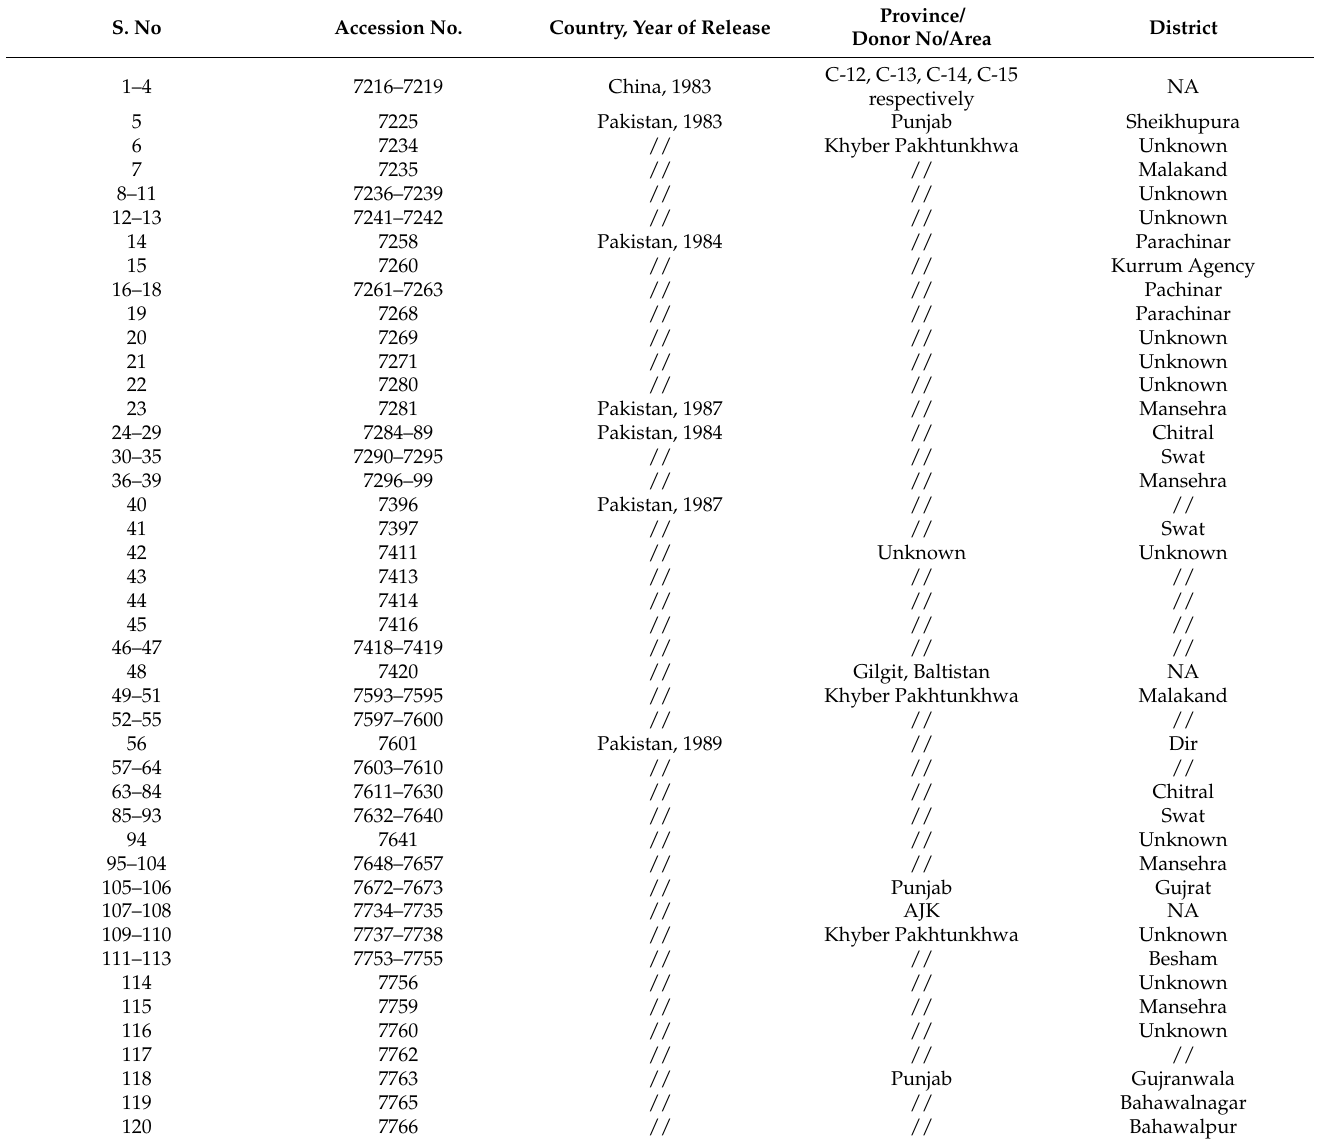
Table 1. Rice ( Oryza sativa L.) genotypes used, provided by IABGR/NARC